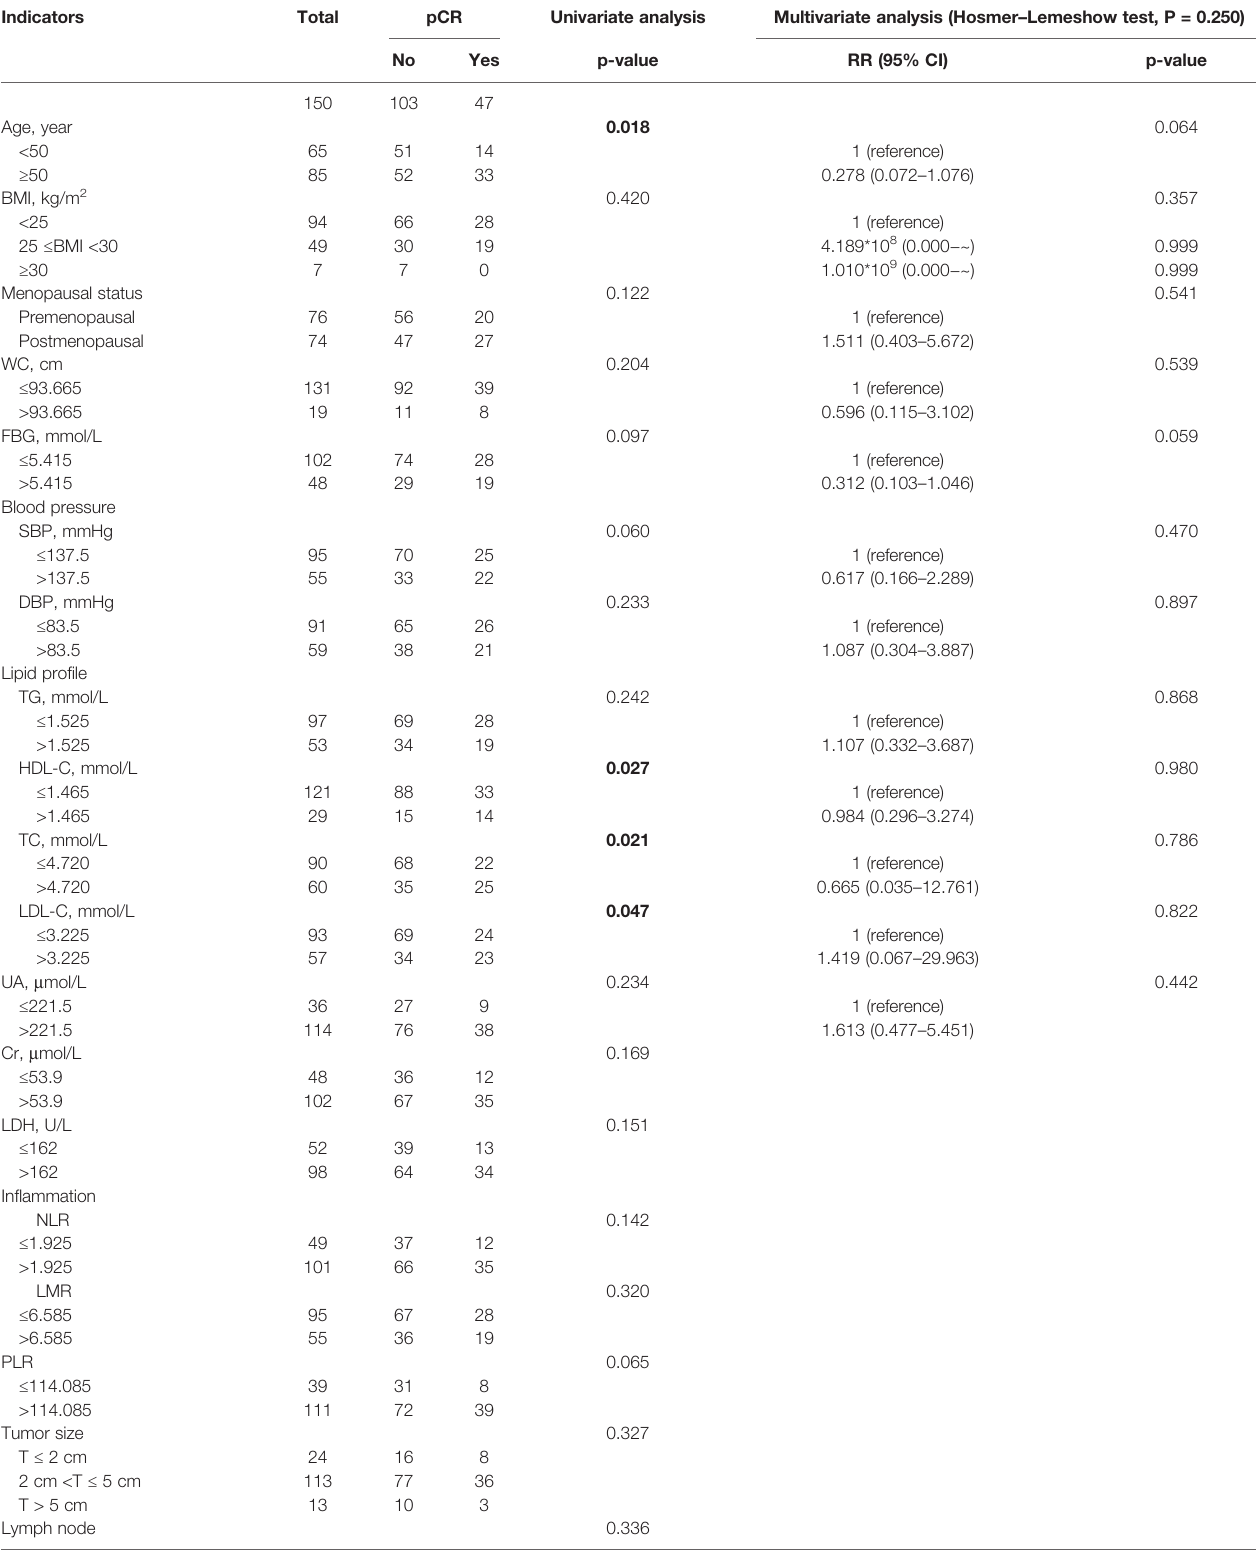
TABLE 2 | Univariate and multivariate analysis of laboratory and clinical indicators with BCNACT pathologic complete response.